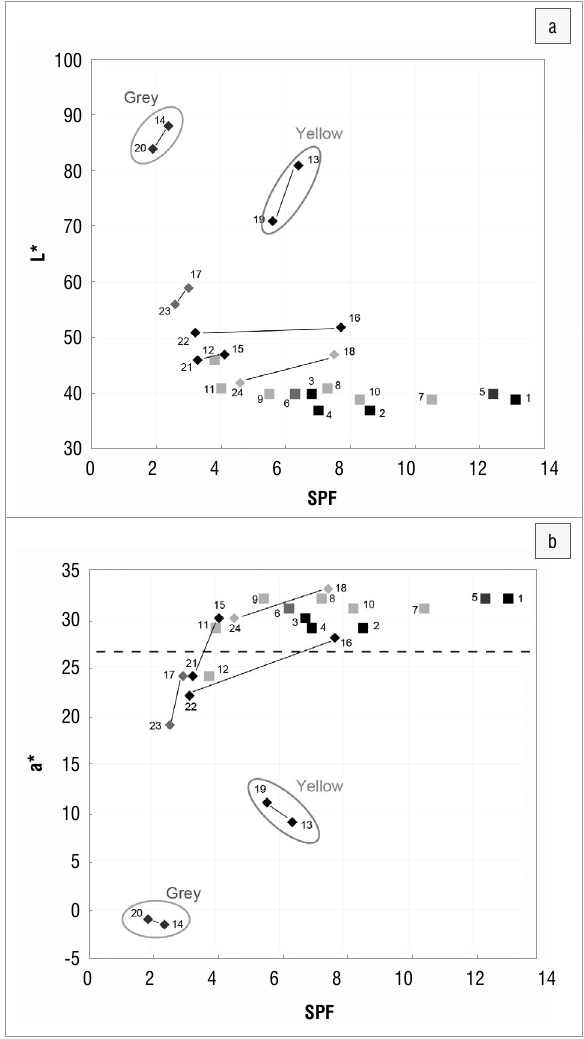
Figure 3: Bipolar plots of sun protection factor (SPF) values in relation to the colourimetric values (a) L* (the lightness–darkness axis) and (b) a* (the red–green